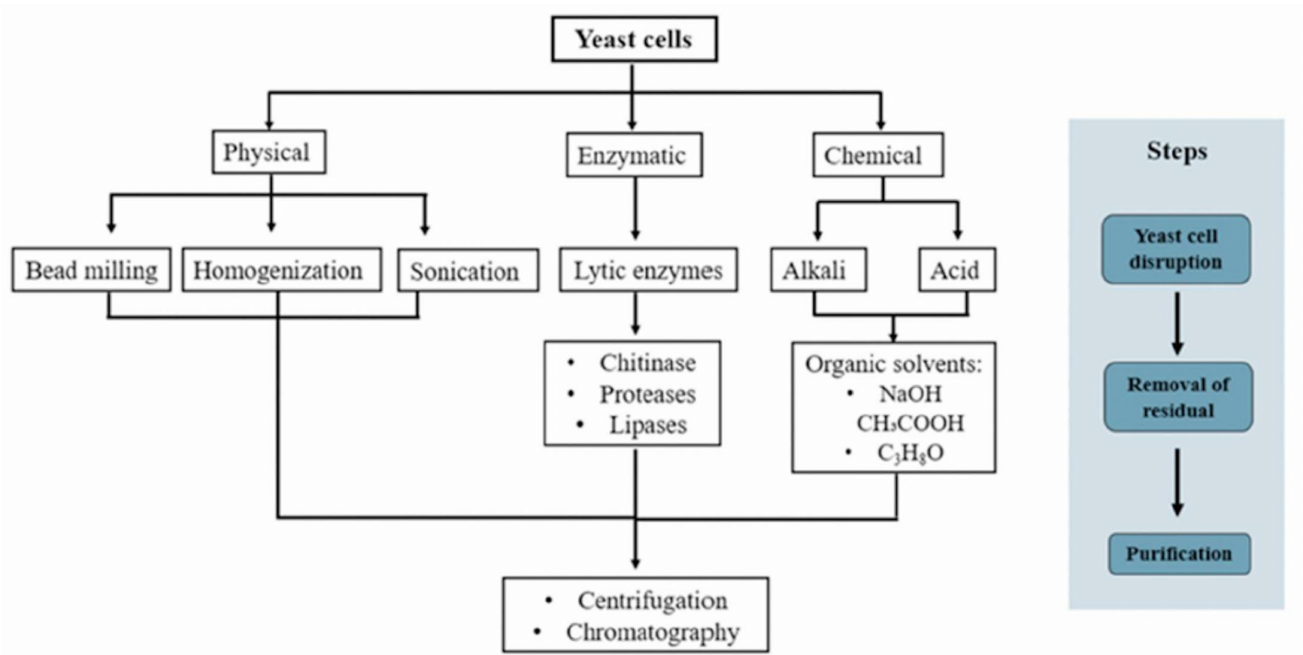
Figure 2. Representative scheme of the methods used for β -glucan extraction from yeast. Method- ologies used for β -glucan extraction from yeast mainly differ in the method of breaking down the cell wall to release the internal components, and in the use of organic solvents to separate them. Finally, a purification process by centrifugation and chromatography is performed to obtain β -glucan from